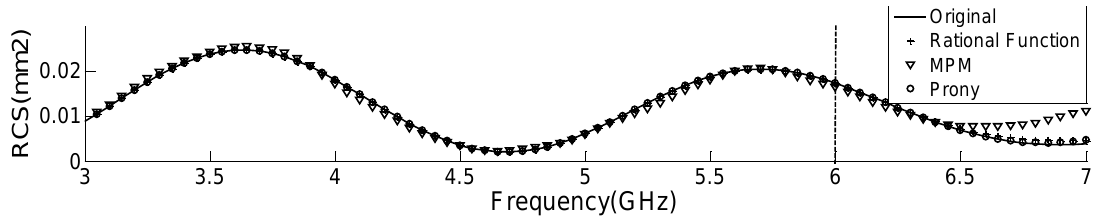
Figure 6. Transport Plane RCS prediction errors at 18 deg.